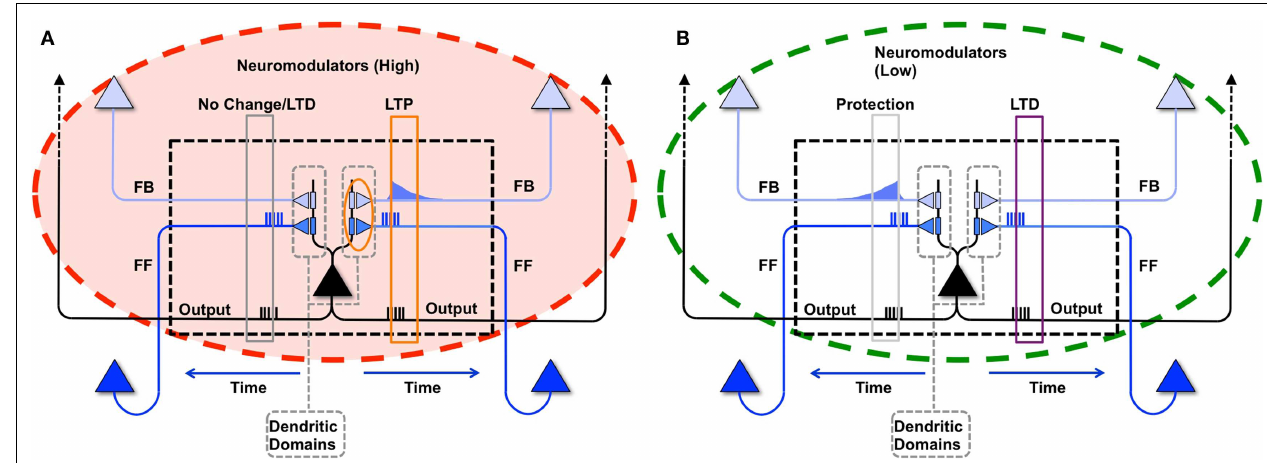
which is missing feedback activity, so either no change happens or LTD is induced. (B) In sleep, global neuromodulators are largely absent.The synapses in a dendritic domain are protected when the neuron is strongly activated by matching feedforward and feedback activations (gray box, left dendritic domain). Conversely, LTD occurs when a neuron fires but its feedforward and feedback are mismatched within a dendritic domain (purple box, right dendritic